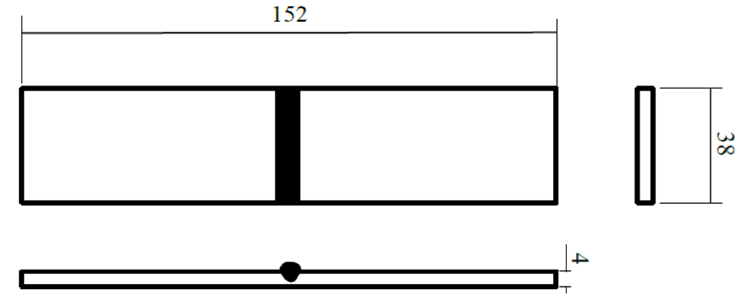
Figure 10. Coupon bending test using the face bend method (mm).